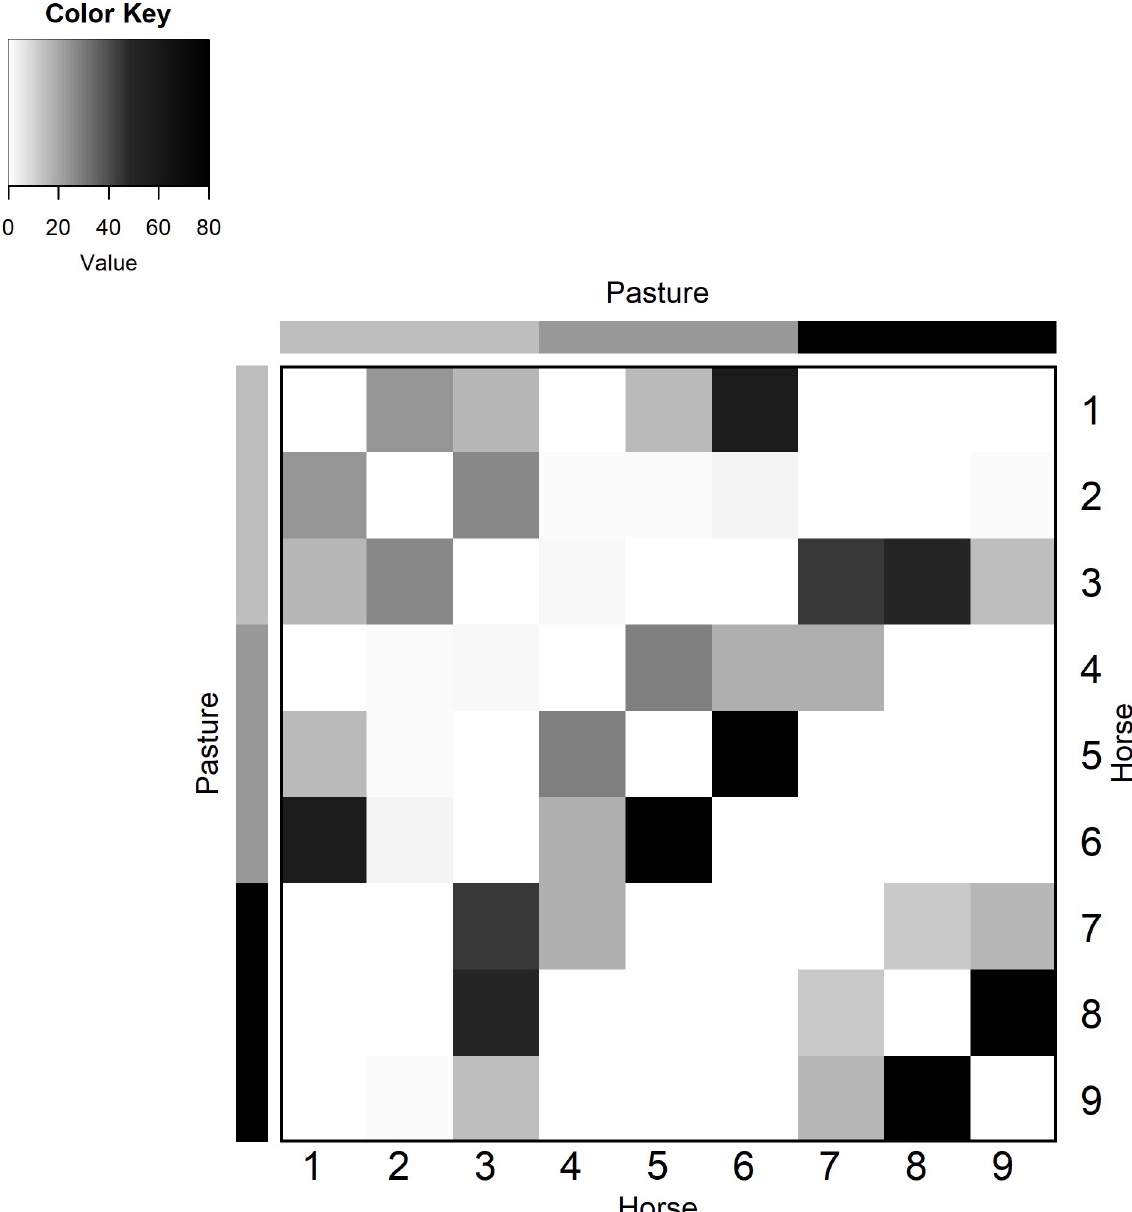
Fig 6. Heat map of the 7 combined dynamic networks. The heat map is not suggestive of homogenous mixing. The colored panels on the left and top axes represent the different clustering of horses by pasture.